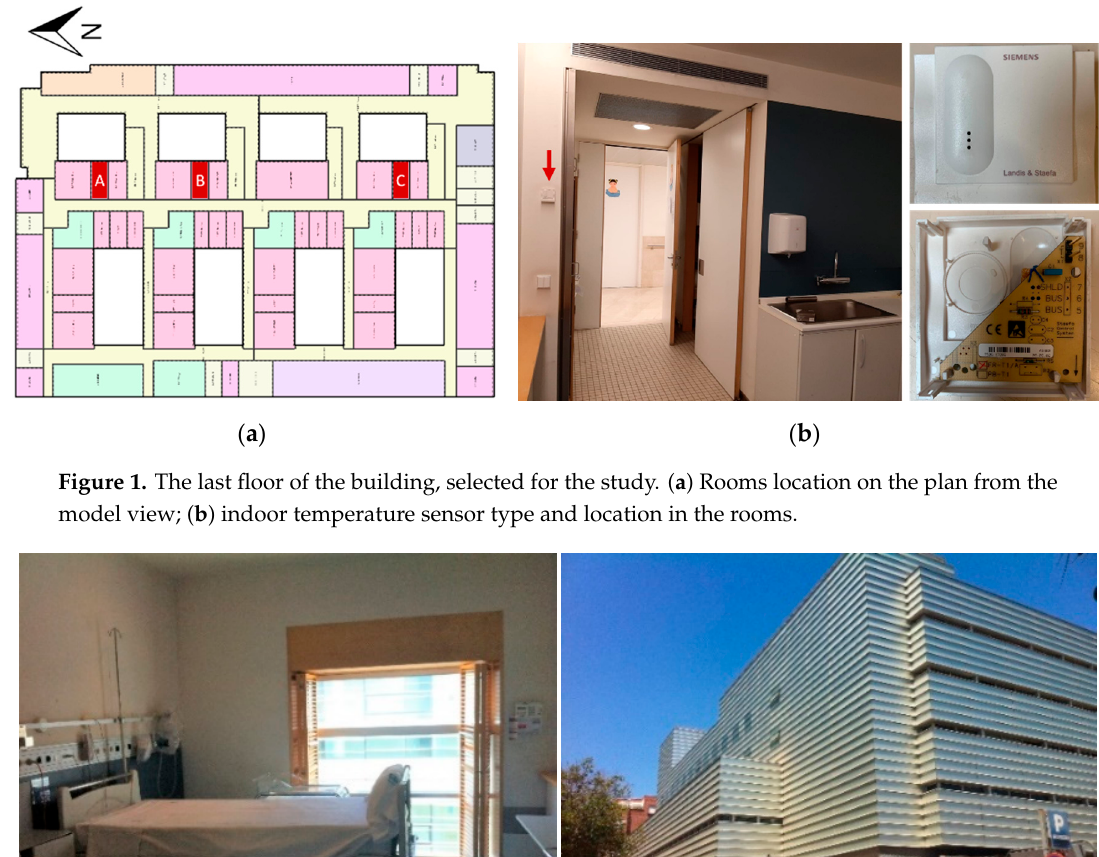
Figure 1. The last floor of the building , selected for the study. ( a ) Rooms location on the plan from the model view; ( b ) indoor temperature sensor type and location in the rooms.